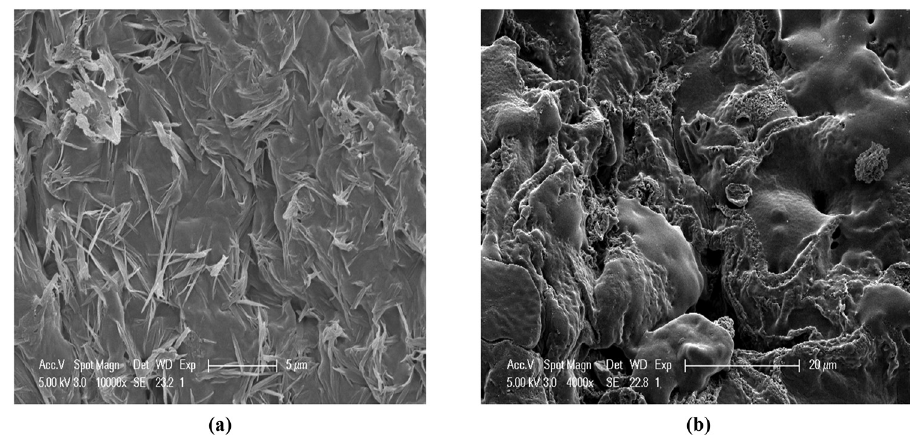
Figure 2: SEM, ( a ) PSBS, and ( b ) PSBS - g -